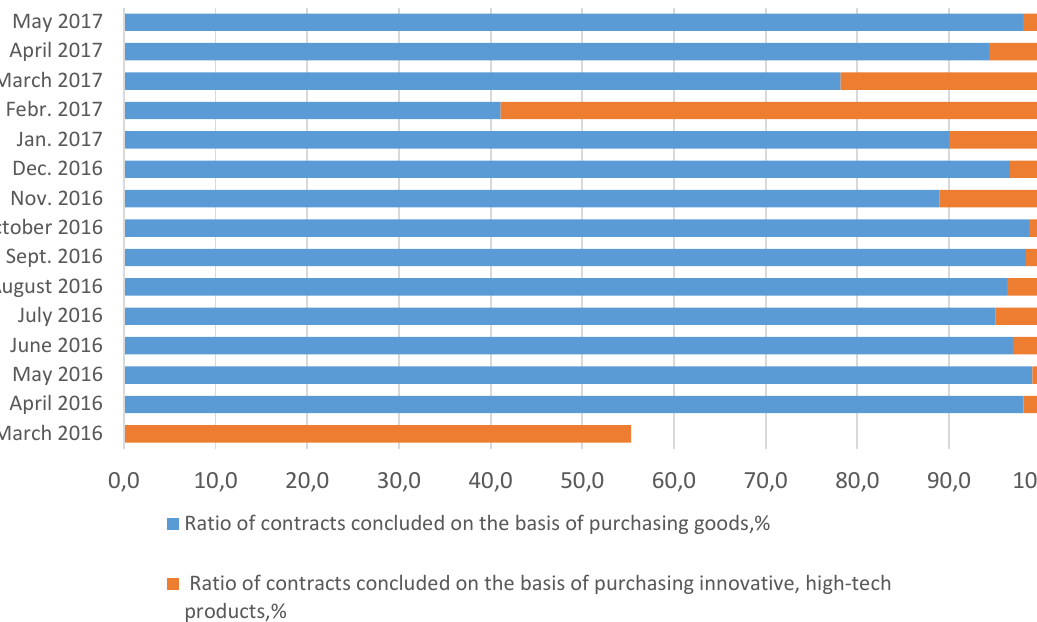
Figure 2. Structure of products purchased in JSC “Russian